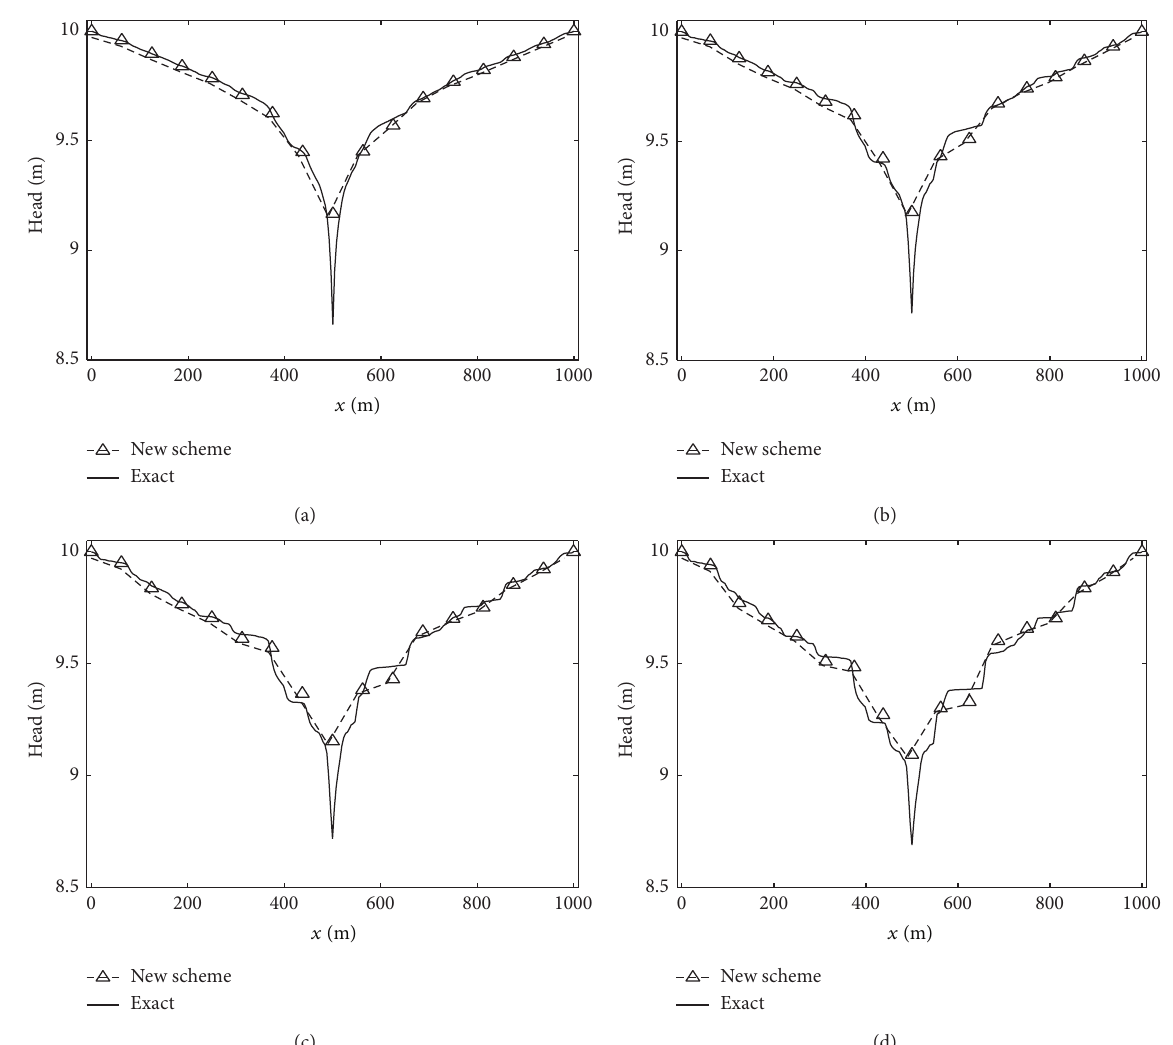
Figure 13: Exact solution and the coarse solution of the new scheme in section 𝑦 = 500 m for the steady well drawdown problem under different well flow rates: (a) 𝑄 = 0.12 , (b) 𝑄 = 0.24 , (c) 𝑄 = 0.36 , and (d) 𝑄 = 0.48 (m 3 (min) −1